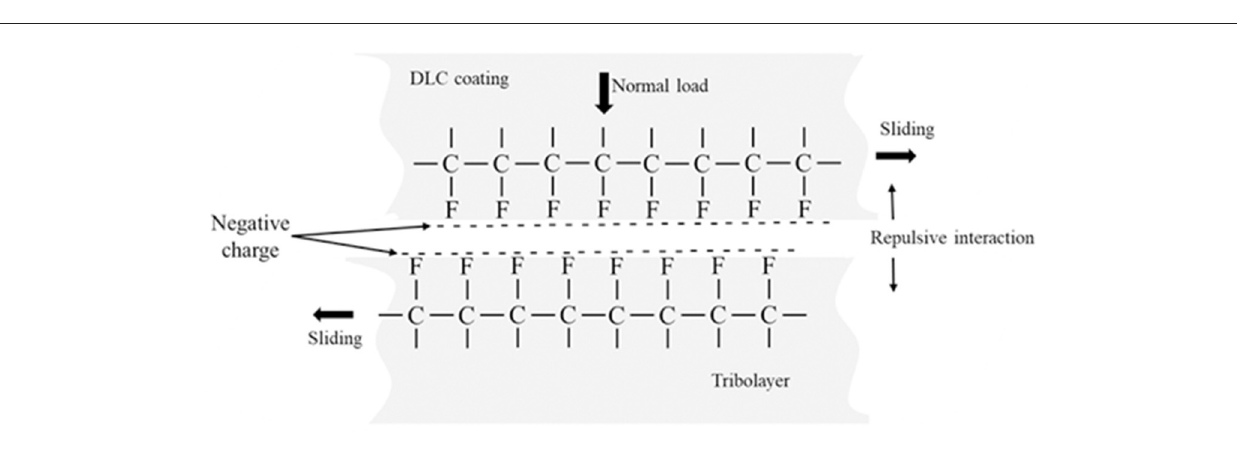
FIGURE 15 | Illustration of the fluorination effect on the repulsive interaction of carbon-based surfaces (Wang et al.,